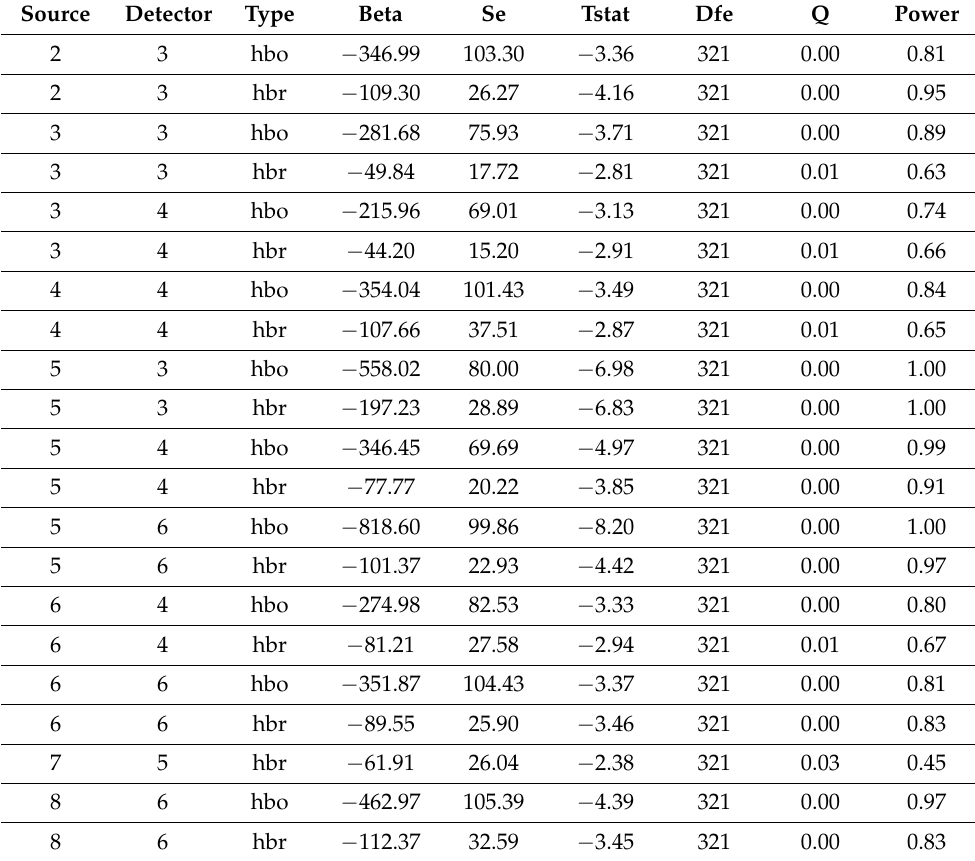
Table A4. t -test statistics for each channel (source–detector pair). Mountain Pose Start–MA Right Knee Bent Bind.